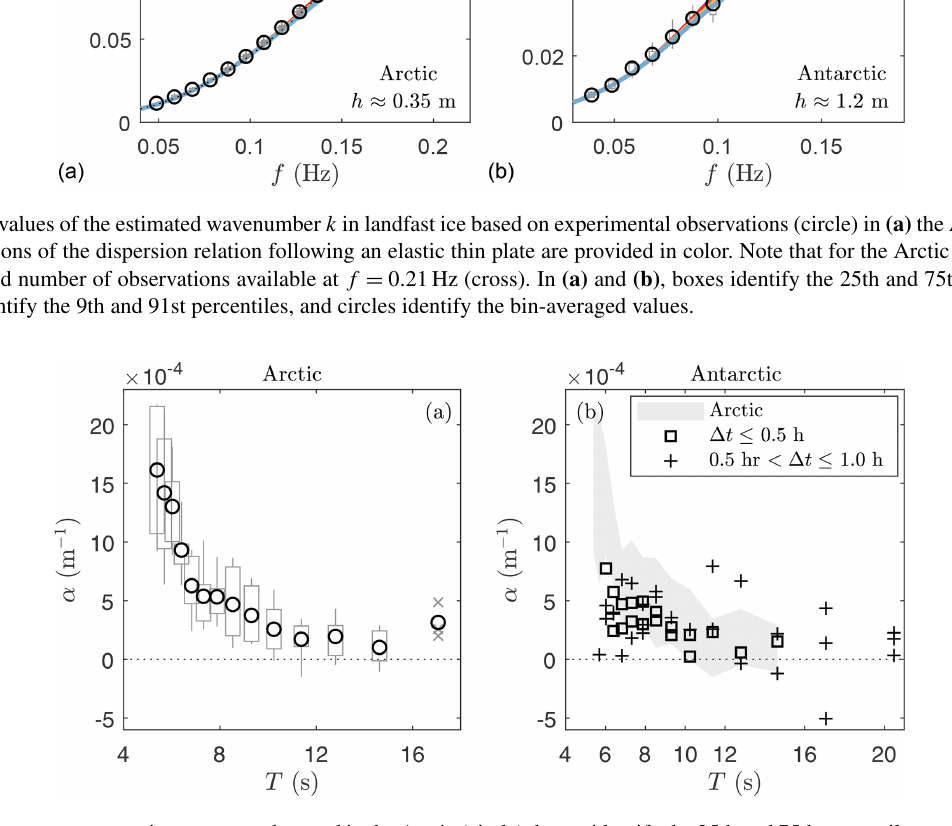
Figure 3. (a) Mean wave attenuation rate α as observed in the Arctic (circle), boxes identify the 25th and 75th percentiles, and the vertical bars identify the 9th and 91st percentiles. Note that the number of observations for T = 17s in the Arctic experiment (cross) is limited. (b) Obser- vations of the wave attenuation rate in the Antarctic with time difference between co-located buoy measurements below 0.5h (square) and between 0.5 and 1.0h (plus). Given the limited number of observations, no mean values are provided for the Antarctic experiment; however, the magnitude of the observations corresponds well with those observed in the